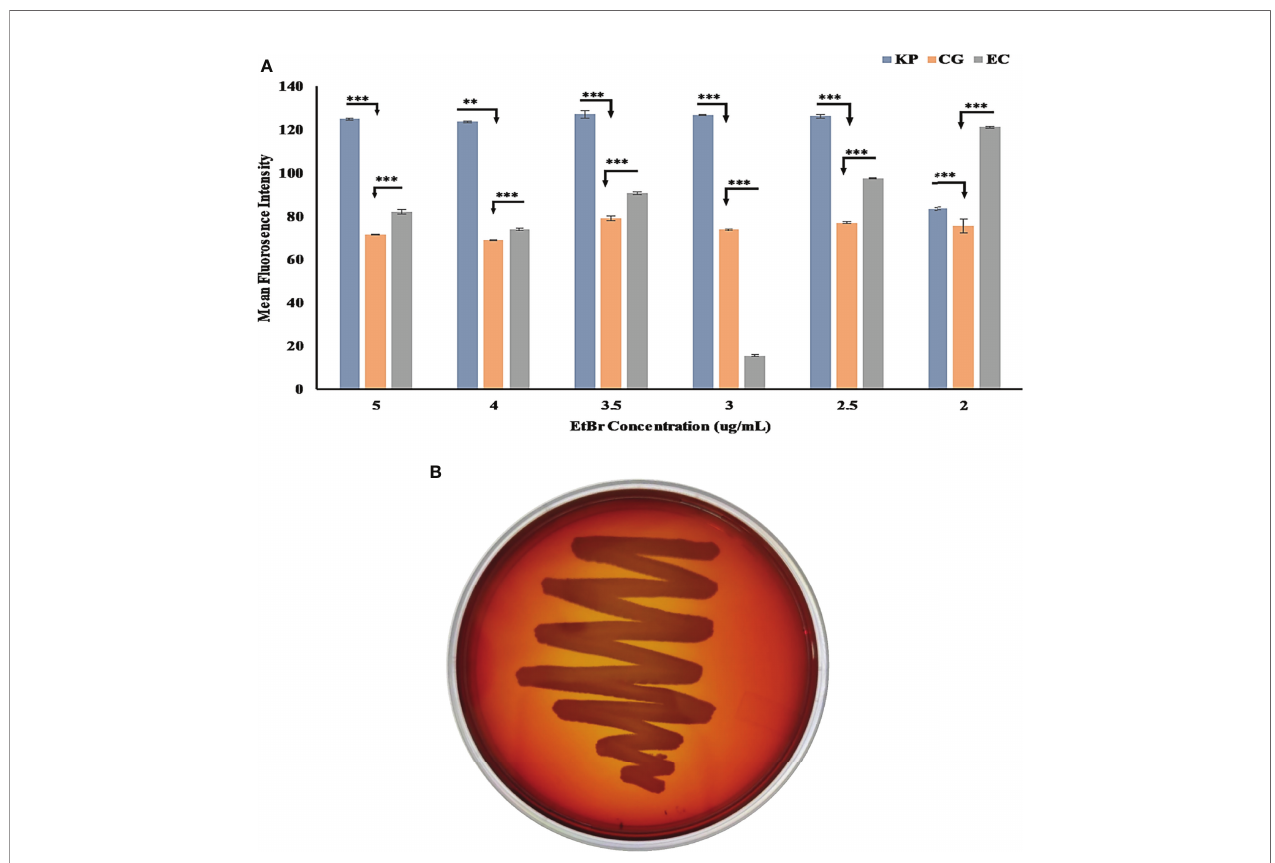
FIGURE 3 | (A) Bar graph of C. gallinarum C42 and K. pneumoniae SDL79 strains along with E. coli ATCC 25922 by the EtBr agar method. The error bar represent the mean standard error, whereas the star represents the signi fi cant difference in ef fl ux activity between pair of SDL79 - MGC42 and ATCC 25922 - MGC42 at different p-value (* <0.05; ** <0.01; *** <0.001). The x-axis represents the concentration of EtBr, and the y-axis represents the mean fl uorescence intensity area value. (B) C. gallinarum MGC42 showing a -hemolysis in greenish color on 5% sheep blood agar plates. Culture was incubated at 37°C for 18 ± 2